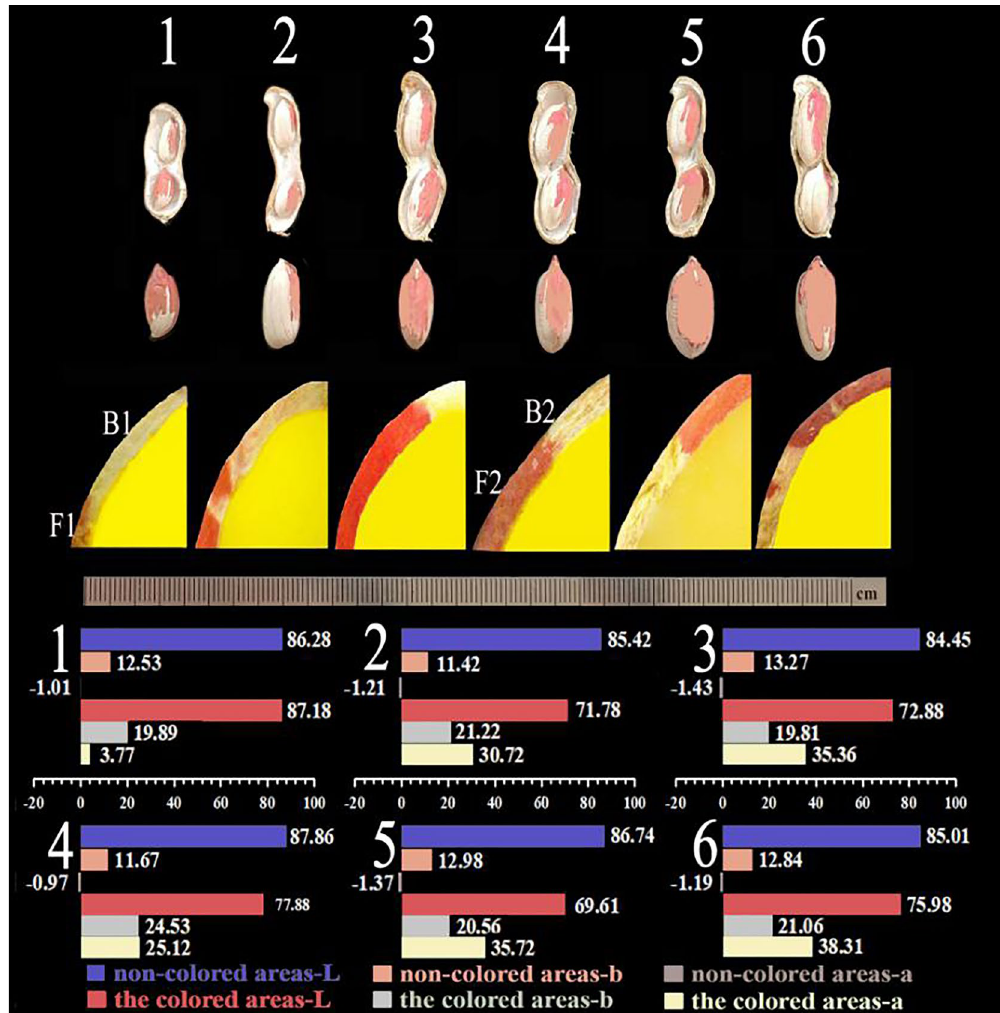
Figure 1. Phenotype and chromatic changes in the synthesis of color in the variegated peanut testa: Numbers 1–6: day at flowering and needling (DAF) 30, 35, 40, 45, 50, and 55 days. F1 and F2 represent the sample names of the pigmented areas at DAF30 and DAF45, respectively. B1 and B2 represent the sample names of the non- pigmented areas at DAF30 and DAF45, respectively. Bar colors represent different values of “a”, “b”, and “L”. The absorbance value “a” (“a” value) represents red and green; the absorbance value “b” (“b” value) represents yellow and blue; and the “L” value represents